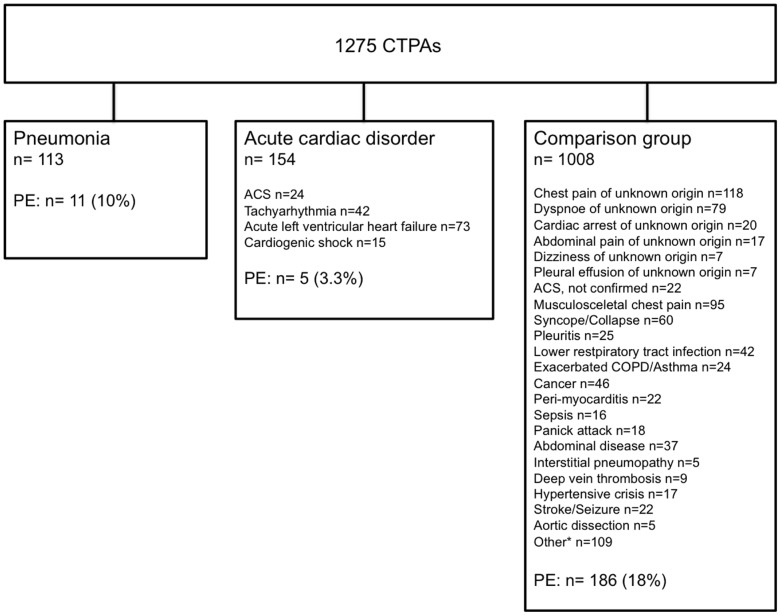
Frequencies of PE in patients with pneumonia, acute cardiac disorder, and in patients of the comparison group.CTPA denotes computed tomography pulmonary angiography. PE denotes acute pulmonary embolism. ACS, not confirmed denotes suspected acute coronary syndrome that was not confirmed by coronary angiography. Patients in the comparison group had either PE or one of the listed diagnoses at discharge from the emergency department. *Other: empyema, hematoma, leg pain or leg swelling of unknown origin, nephrotic syndrome, pneumothorax, obesity hypoventilation syndrome, sickle cell crisis, sinusitis, tuberculosis, malaise of unknown origin, fever of unknown origin, paralysis, elevated D-dimers of unknown origin, hemoptysis of unknown origin, cough of unknown origin, epiglottitis, hepatic encephalopathy, coma of unknown origin, anemia, ketoacidosis, anaphylactic reaction, struma, intoxication, spondylodiscitis, sternum infection, knee arthritis.